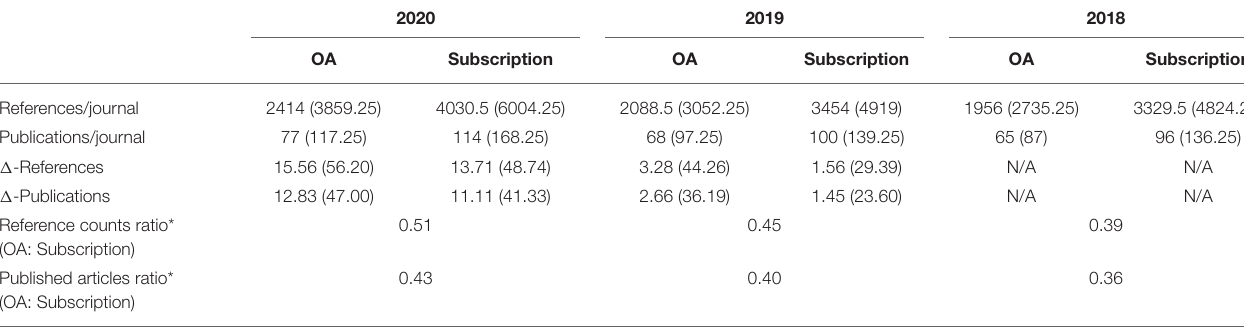
TABLE 3 | The characteristics of open-access vs. subscription biomedical journals between 2018 and 2020.